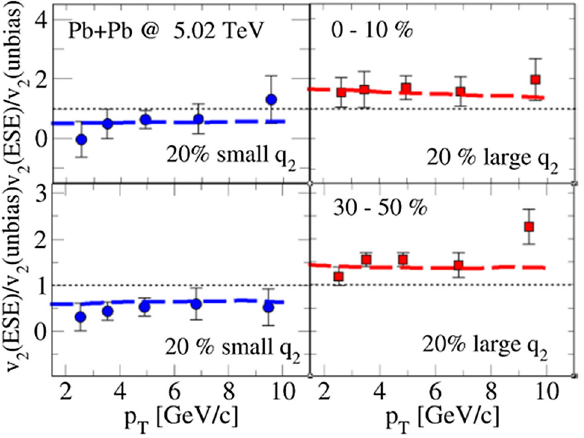
Fig. 8 Ratio of the average D meson v 2 coefficients measured in the 20% large- q 2 (right panel) and 20% small- q 2 (left panel) events with respect to that of the unbiased sample as a function of p T . These cal- culation are for for PbPb collisions at 5 . 02 TeV for two centralities 0–10% (upper panels) and 30–50% (lower panels). The experimental data are taken from ALICE measurements